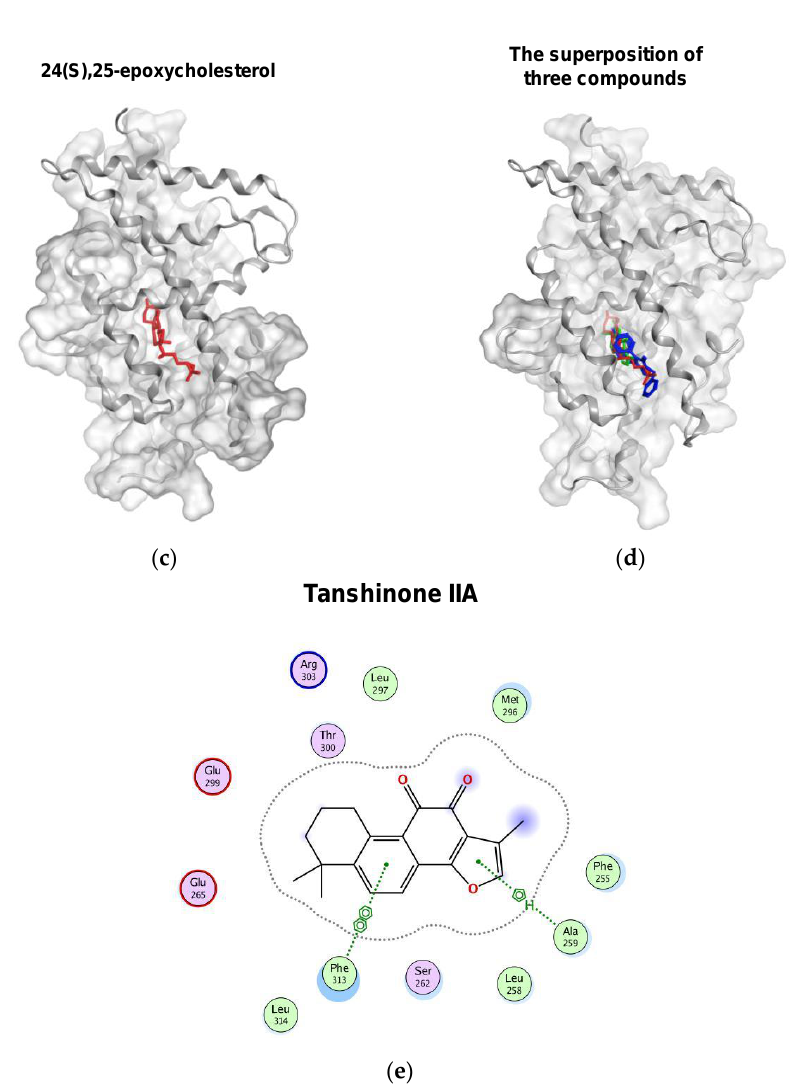
Figure 9. Tanshinone IIA docks to the ligand-binding domain of LXR α . The poses of compounds docked preferentially to the ligand-binding domain of LXR α . The receptor is shown as a gray ribbon, and the compounds are shown in ( a ) green (tanshinone IIA), ( b ) blue (T0901317), and ( c ) red (24(S),25-epoxycholesterol). ( d ) The superposition of these three compounds bound to the ligand-binding domain pocket of LXR α . Two-dimensional interaction map of LXR α with ( e ) tanshinone IIA. Many hydrophobic amino- acid residues (green color) surrounded the tanshinone IIA.